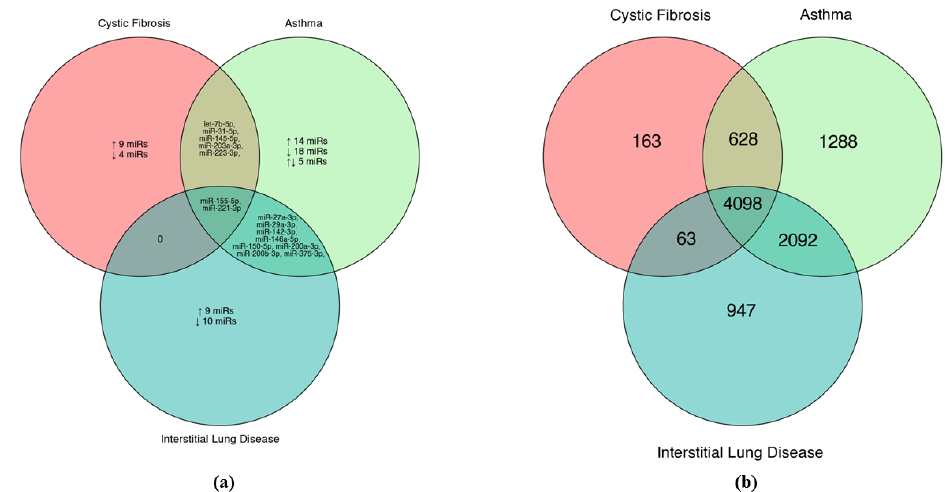
Figure 2. Venn diagrams of ( a ) disease-differentiating miRNAs studied in selected biomaterials, with ( ↑ / ↓ ) indicating disease direction of expression and ( b ) predicted gene targets of miRNAs differentiating selected diseases, acquired through miRDip database. Developed with RStudio.